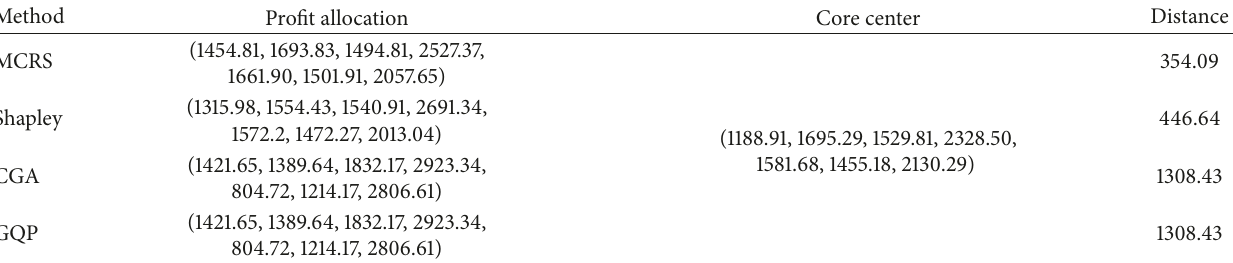
Table 10: Core center and distance comparison